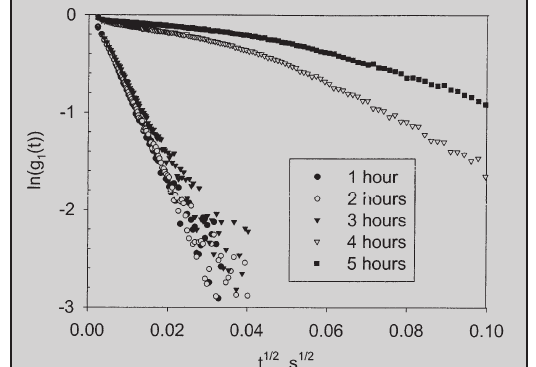
Figure 2 (left): The evolution of the short-delay-time part of the normalized field correlation function during acidifi- cation/gelation process in a sample of AMG prepared with 2 % GDL. Figure 3 (right): The mean square displacement in time domain calculated for the samples of AMG prepared with different amounts of GDL after 5 hours of gelation: 1.8%, 1.9%(inset), 2.0%, 2.1% (inset) and